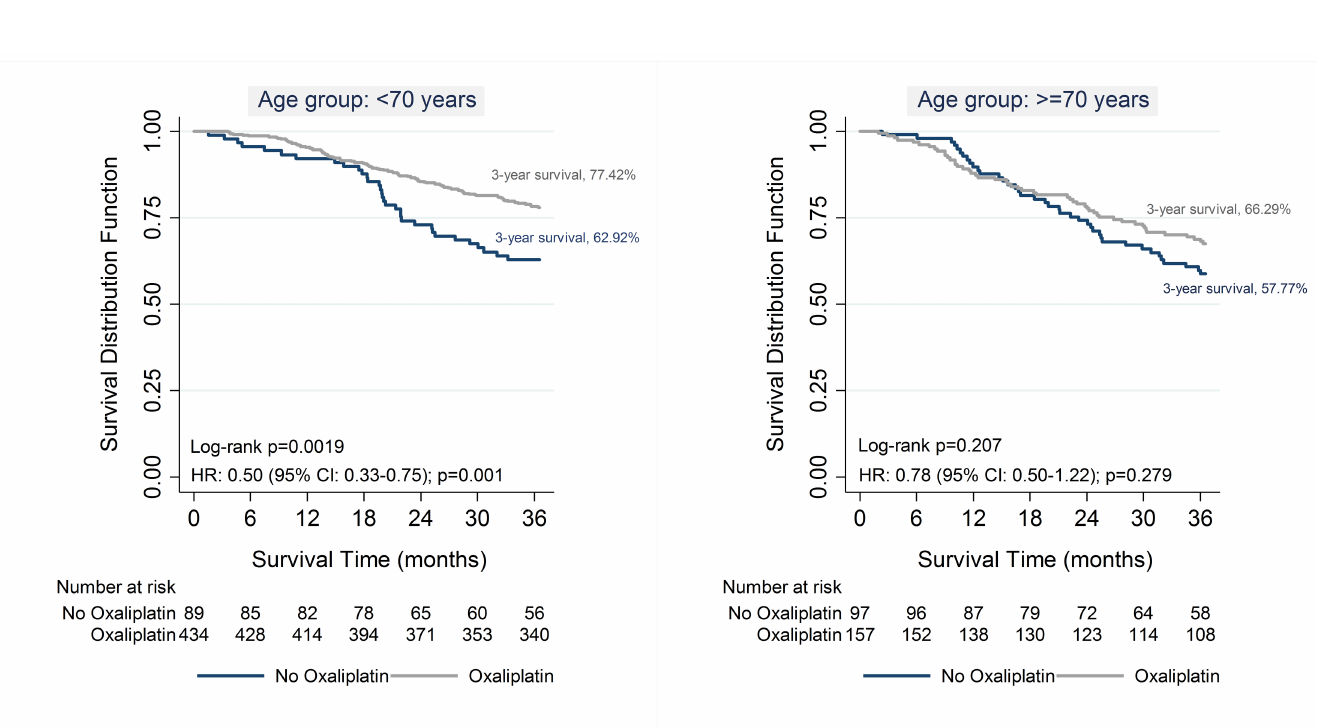
PLOS ONE | https://doi.org/10.1371/journal.pone.0194415 March 27, 2018 10 /